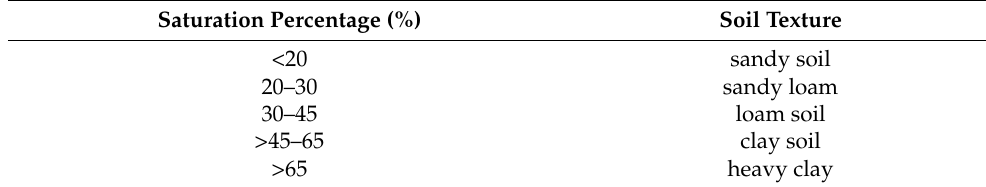
Table 2. Classification of soil based on saturation percentage (SP).